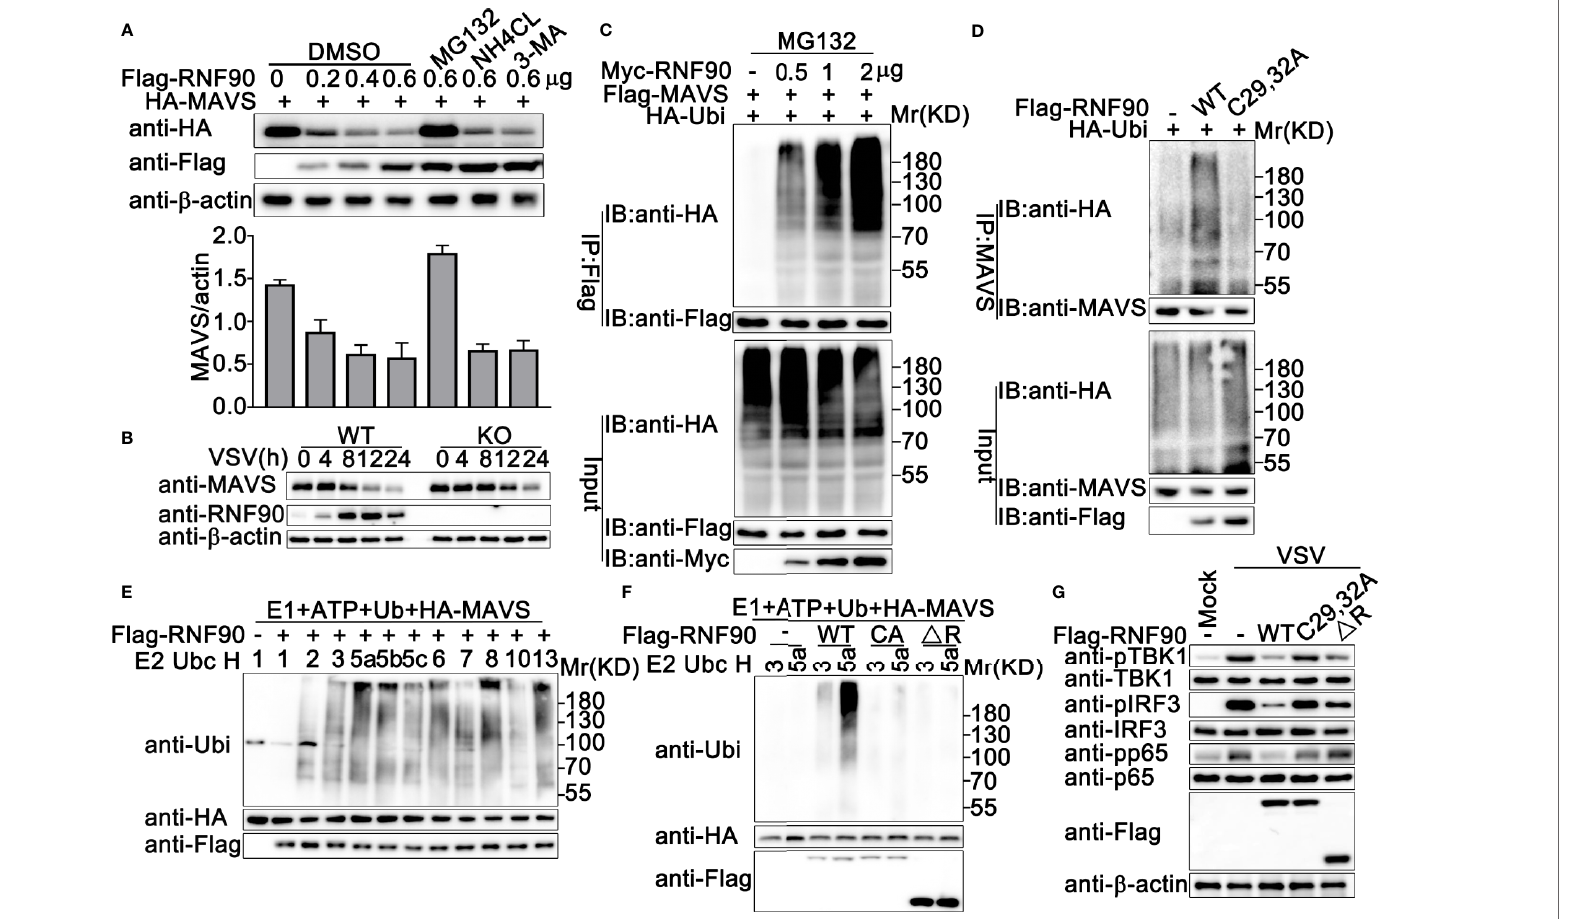
FIGURE 9 | RNF90 enhances the degradation of MAVS (A) HEK293T cells were transfected with HA-MAVS and the increasing amounts of RNF90 plasmids as indicated. 24 h later, cells were treated with DMSO as control, MG132 (20 mM), NH 4 CL (5 mM), or 3-MA (2 mM) separately for 6 h and lysed for immunoblot assays (Top). The quantity of MAVS expression was normalized by b -actin (Bottom). (B) WT and RNF90- de fi cient (KO) HaCaT cells were infected with VSV (MOI = 1) for indicated time points, and the cell lysates were then subjected to immunoblot analysis. b -actin served as a loading control in all the immunoblot assays. (C) HEK293T cells were transfected with the indicated plasmids and increasing amounts of Myc-RNF90 (0, 0.5, 1, and 2 m g). 24 h later, cells were treated with MG132 (20 mM) for 6 h. Then, the cells were lysed and subjected to immunoprecipitation (IP) and immunoblot (IB) analysis. (D) HEK293T cells were transfected with HA-Ubiquitin (Ubi) plasmid, with empty vector (-), WT Flag-RNF90, or C29, 32A mutant plasmid. At 24 h after transfection, the cells were lysed and subjected to immunoprecipitation (IP) and immunoblot (IB) analysis. (E, F) Immunoblot analysis of MAVS ubiquitination in vitro . MAVS and WT RNF90 (E) or its mutants (F) were quickly translated in vitro , and the biotin-ubiquitin E1 and indicated E2s were added for the in vitro ubiquitination assays. Ubiquitination of MAVS was detected by anti-Ubi. (G) RNF90- de fi cient MEFs were transfected with indicated plasmids. At 24 h after transfection, the cells were infected with VSV (MOI = 1) for 4 h, and then the cell lysates were subjected to immunoblot analysis. The data are representative of three independent